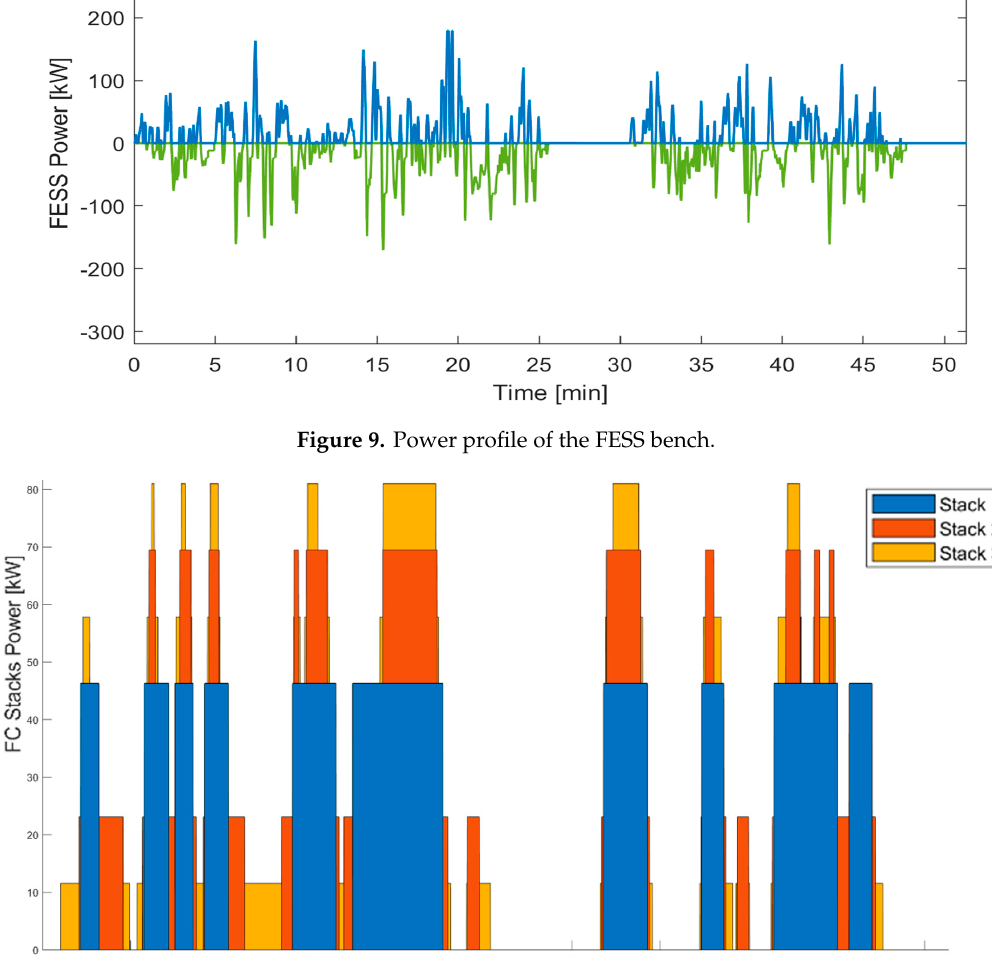
Energies 2020 , 13 , x FOR PEER REVIEW Figure 10. FC stacks partitioning and activation. Figure 10. FC stacks partitioning and activation.